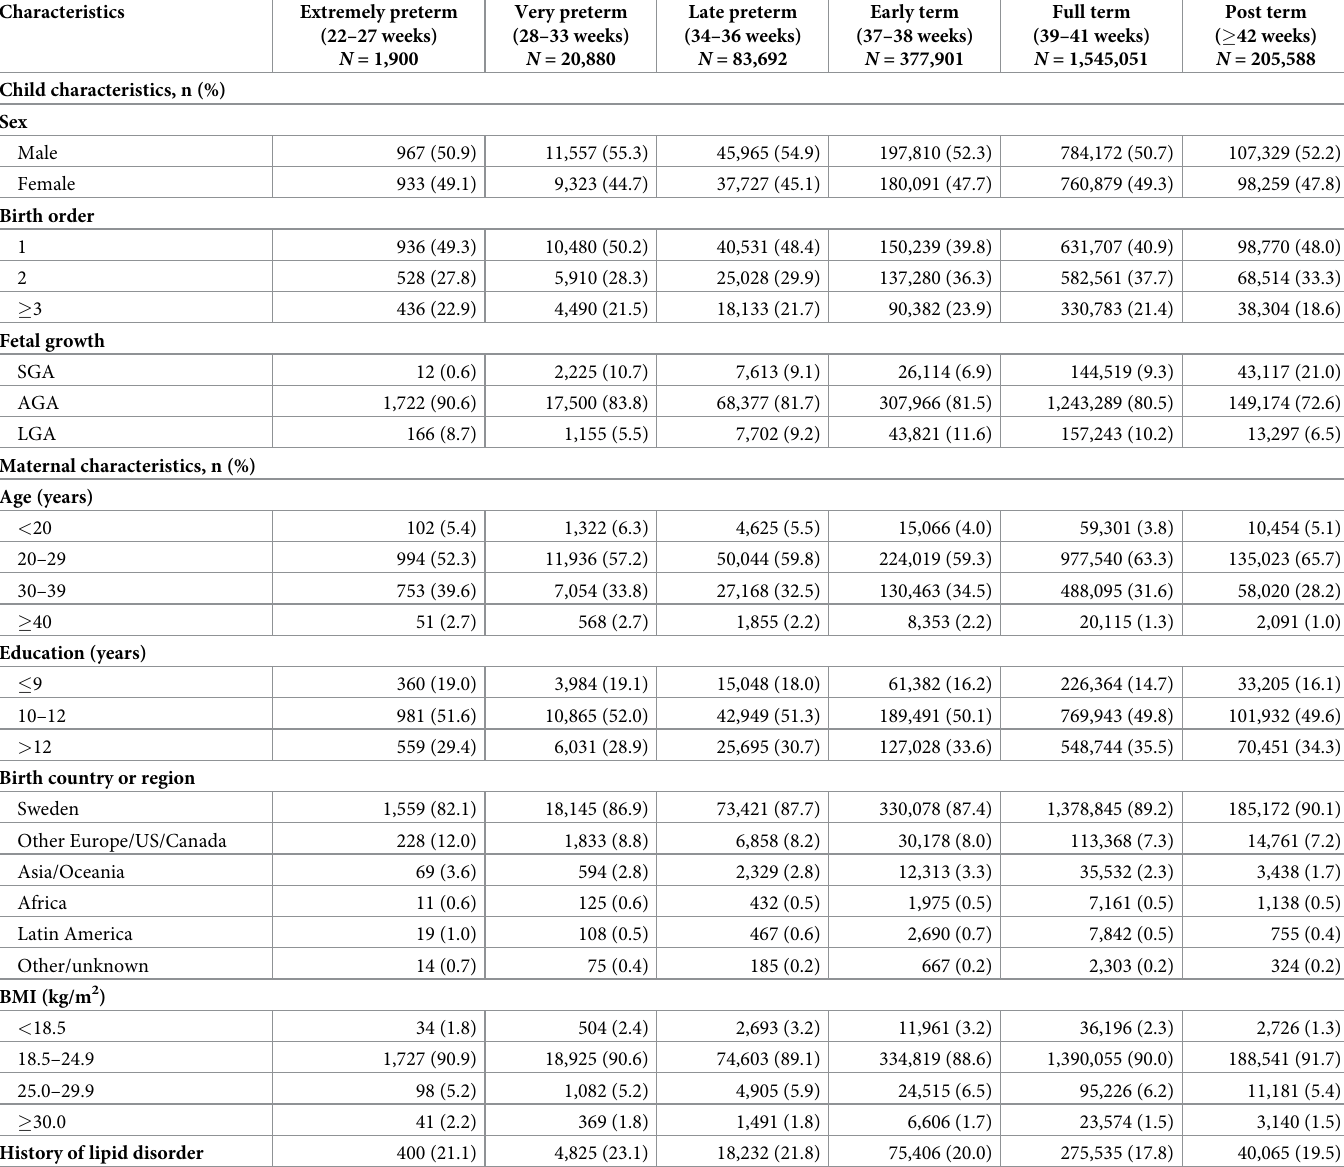
Table 1. Characteristics of study participants by gestational age at birth, Sweden, 1973–1995.